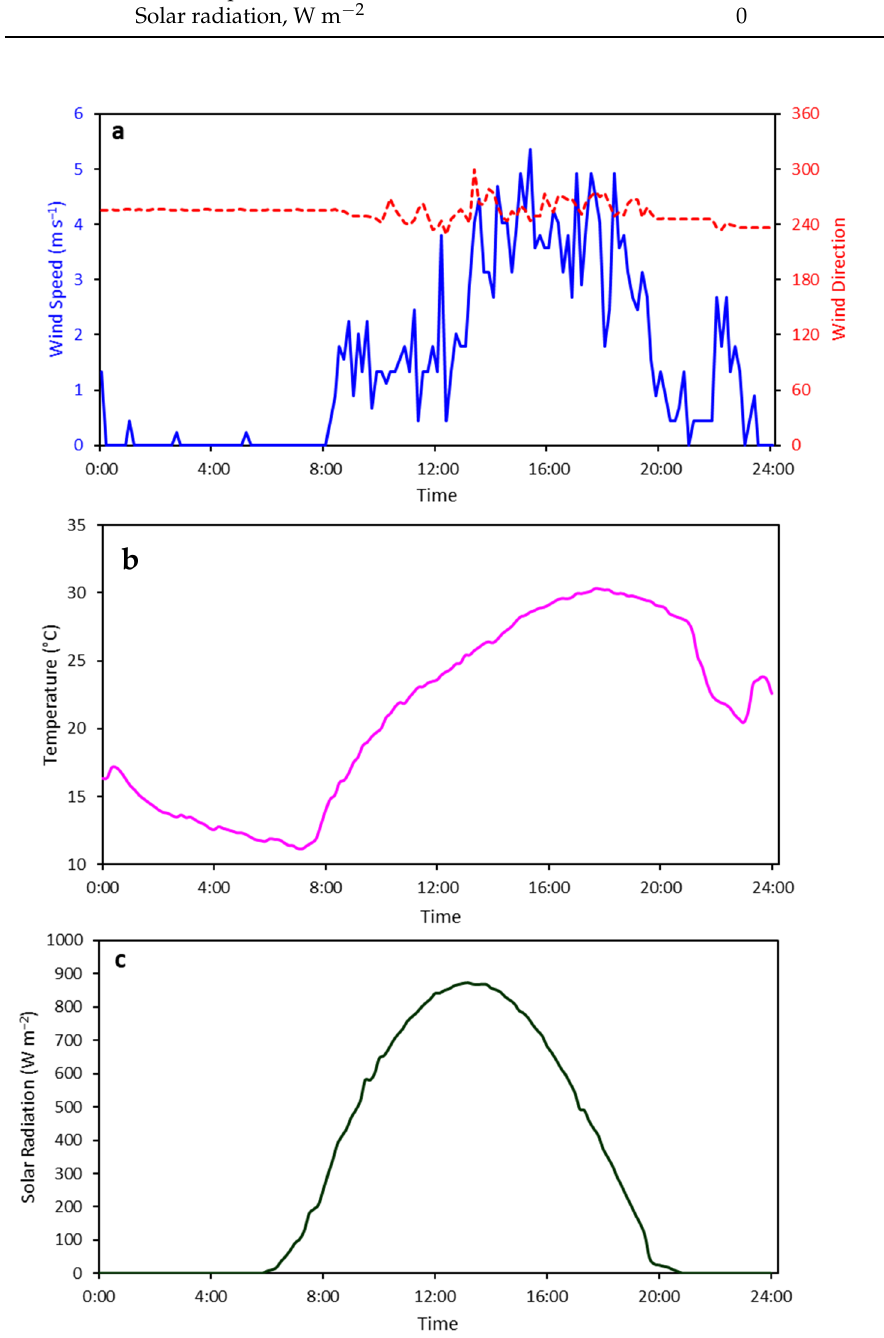
Figure 5. Measured outside wind speed and wind direction at 2.5 m ( a ), measured outside temperature ( b ), and measured solar radiation ( c ) on 13 July 2019. Note that the experimental high tunnel was oriented in such a way that a wind direction of approximately 260° would be perpendicular to the roll-up side vents and entering the windward vent first. Table 3. Material properties used during the CFD simulations.